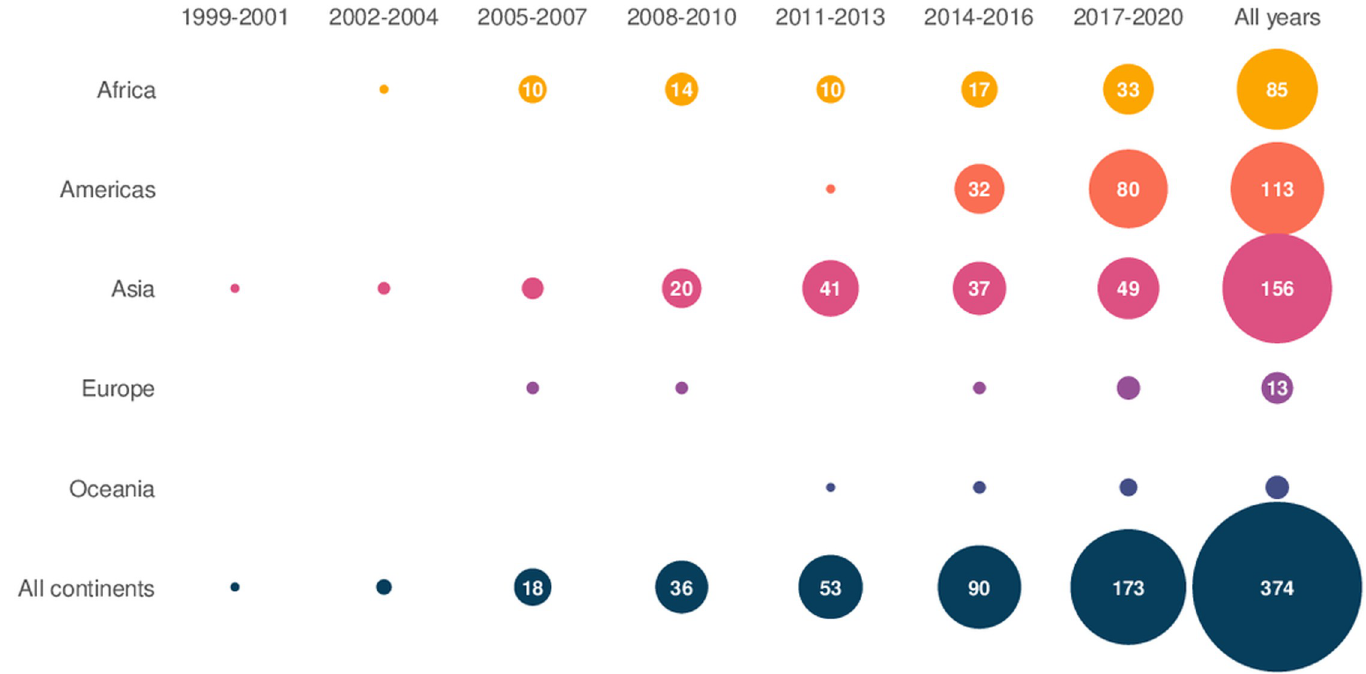
Fig 2. Number of references per year of publication and region of study setting. Circles are proportional to the number of studies. Circles with values lower than 10 are not labeled. Three references reported research in more than one region.